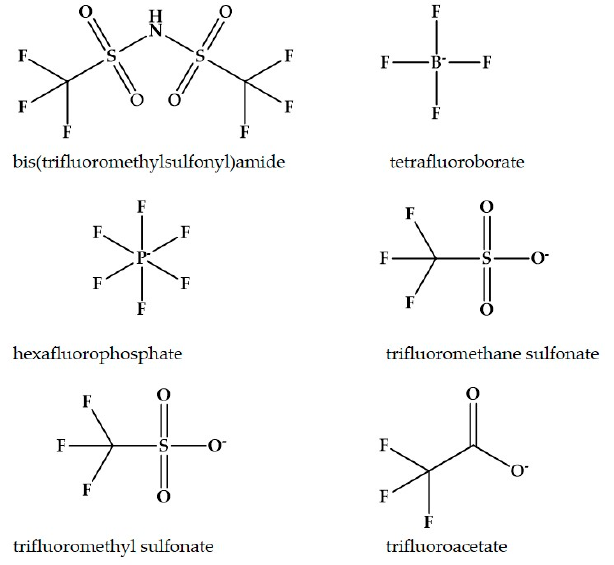
Figure 5. Schematic showing the structure of commonly used anions for preparing the ILs that are employed for the deposition of Al. employed for the deposition of